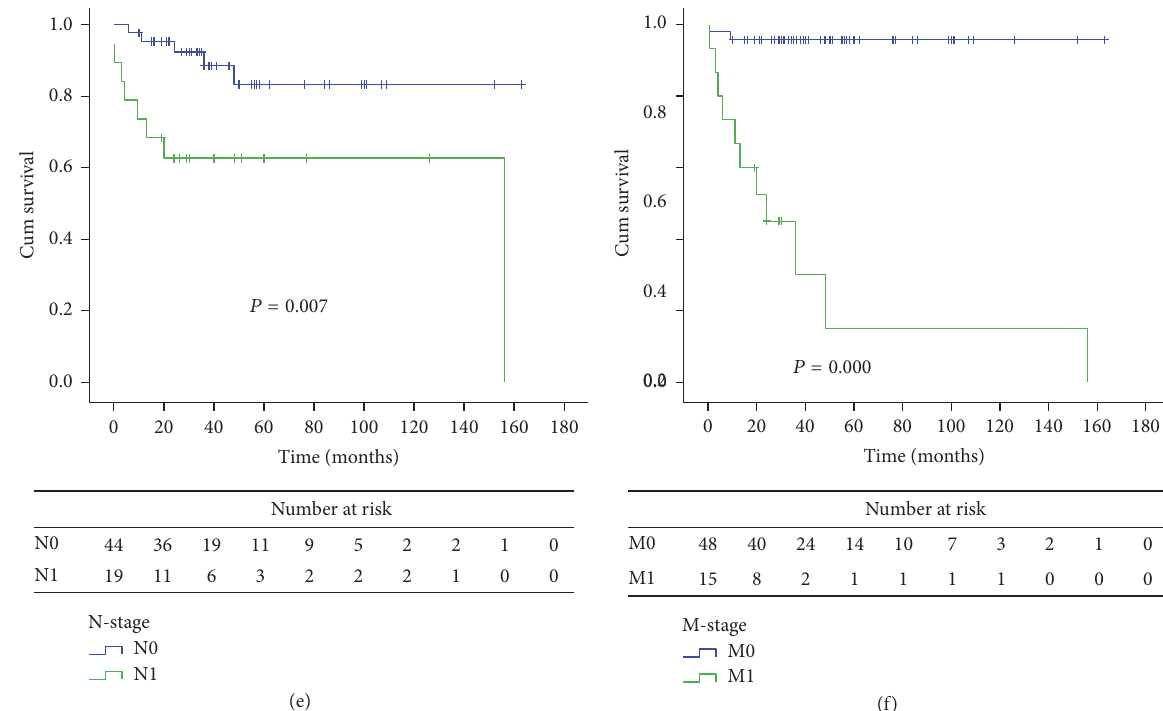
Figure 1: (a) Overall survival based on tumor location. (b) Overall survival based on tumor size. (c) Overall survival based on pathological classification. (d) Overall survival based on T-classification. (e) Overall survival based on N-classification. (f) Overall survival based on M-